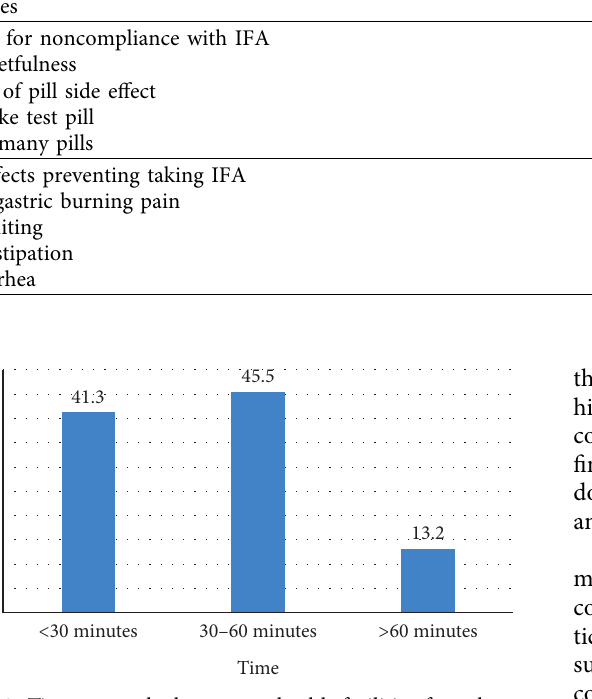
Figure 2: Time to reach the nearest health facilities from home among pregnant women attending antenatal care, Shalla district health facilities, West Arsi Zone, Southwest Ethiopia, 2011 ( N � 402).